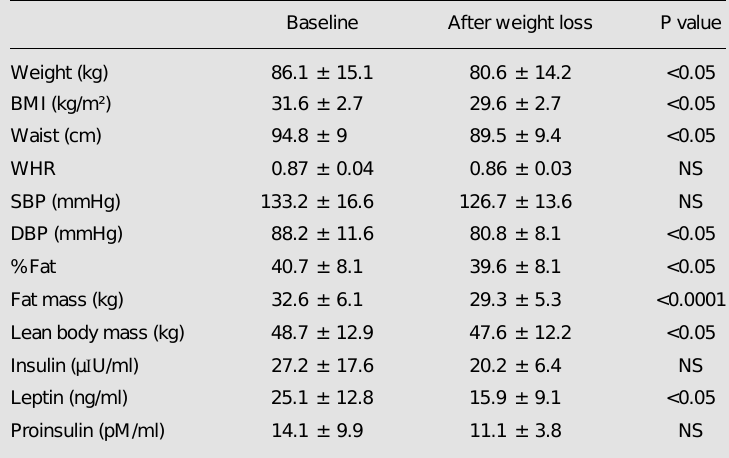
Table 3 - Clinical, anthropometric and hormonal parameters of obese subjects submit- ted to a weight loss program, at baseline and after weight loss. Data are reported as means ± SD. BMI, Body mass index; WHR, waist-to-hip ratio; SBP, systolic blood pressure; DBP, diastolic blood pressure; NS, not